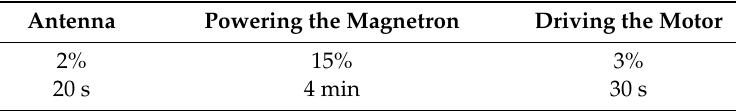
Table 3. Overall results during optimisation of range.